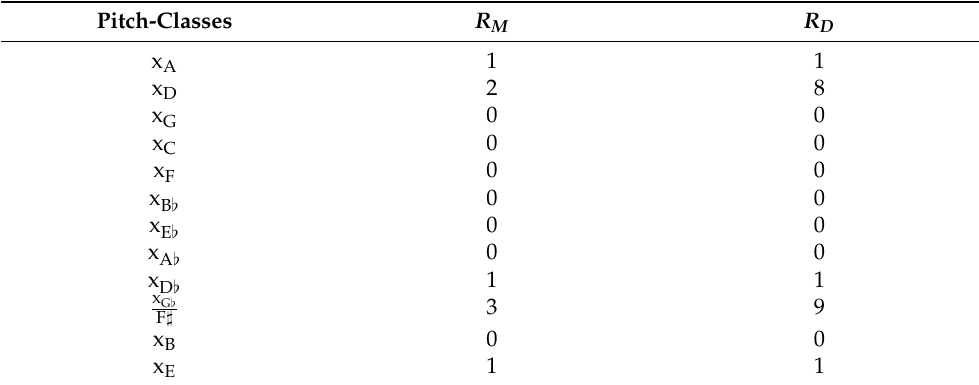
Figure 1. The analyzed fragment of a sample music piece. Table 1. The values of the quarter-note multiplicities of occurrences ( 𝑅 𝑚 ) and aggregate durations ( 𝑅 𝐷 ) associated with individual pitch-classes of the chromatic scale, obtained for the fragment of music shown in Figure 1.